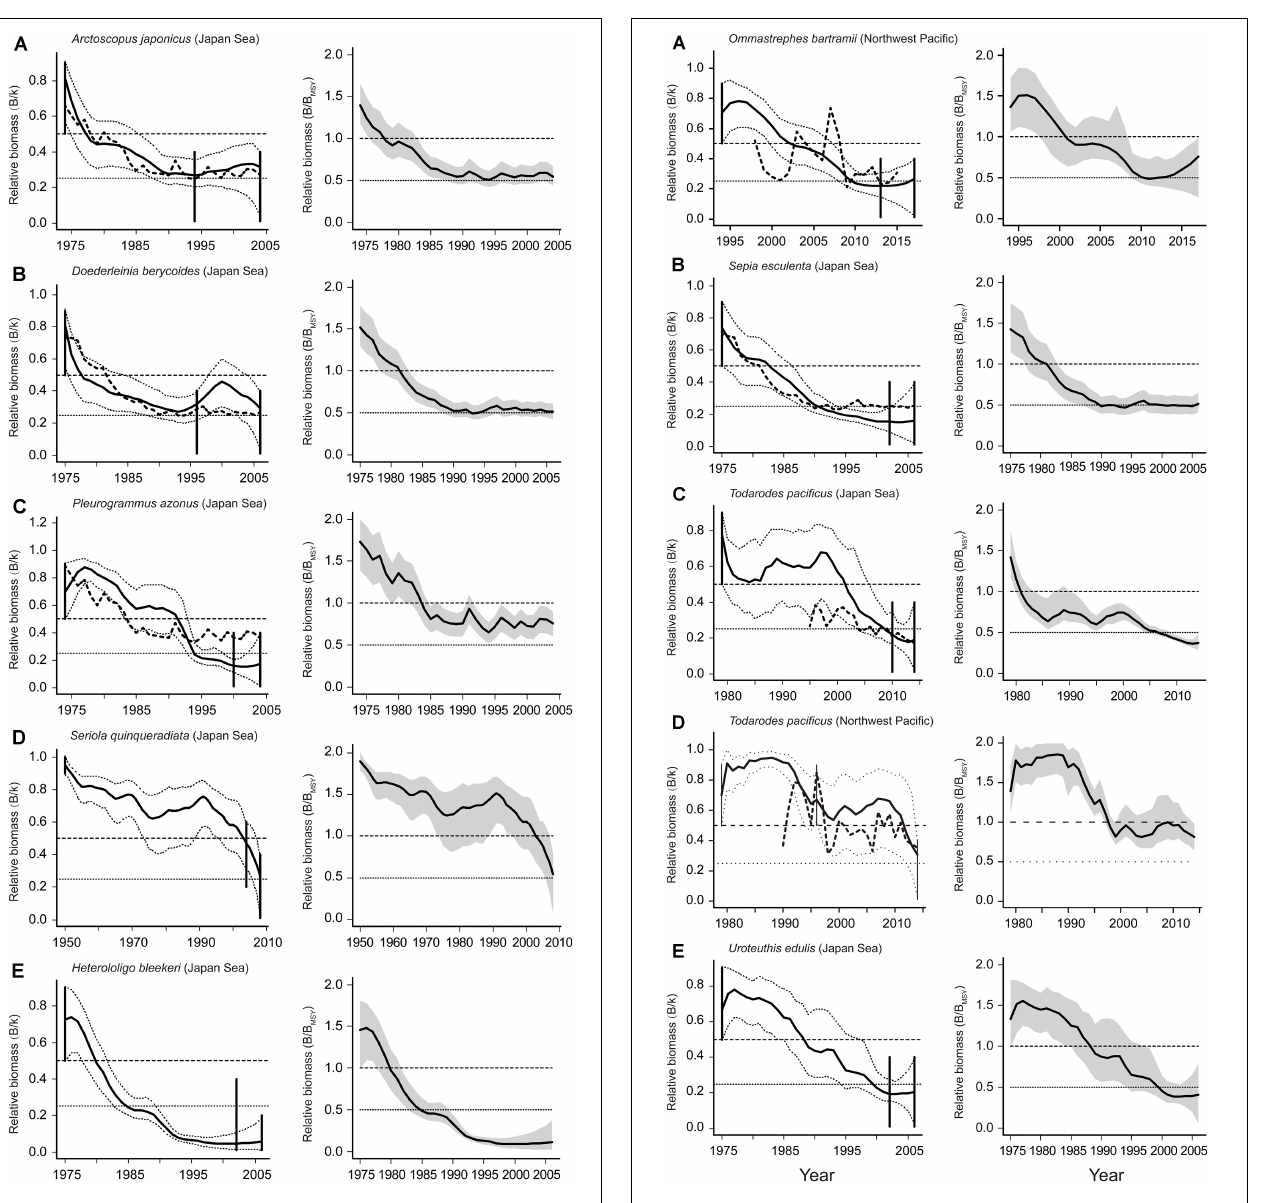
FIGURE 4 | Estimated biomass and the development of relative biomass of 5 stocks assessed ( A–D in BSM, E in CMSY). Estimated biomass trajectories (left panels) from CPUE by BSM (bold dashed line) and catch by CMSY (bold solid line), with 95% confidence limits (dashed lines), and vertical lines represented prior biomass ranges. The trajectories of relative total biomass ( B/B MSY ) are shown (right panels) with the gray areas indicating